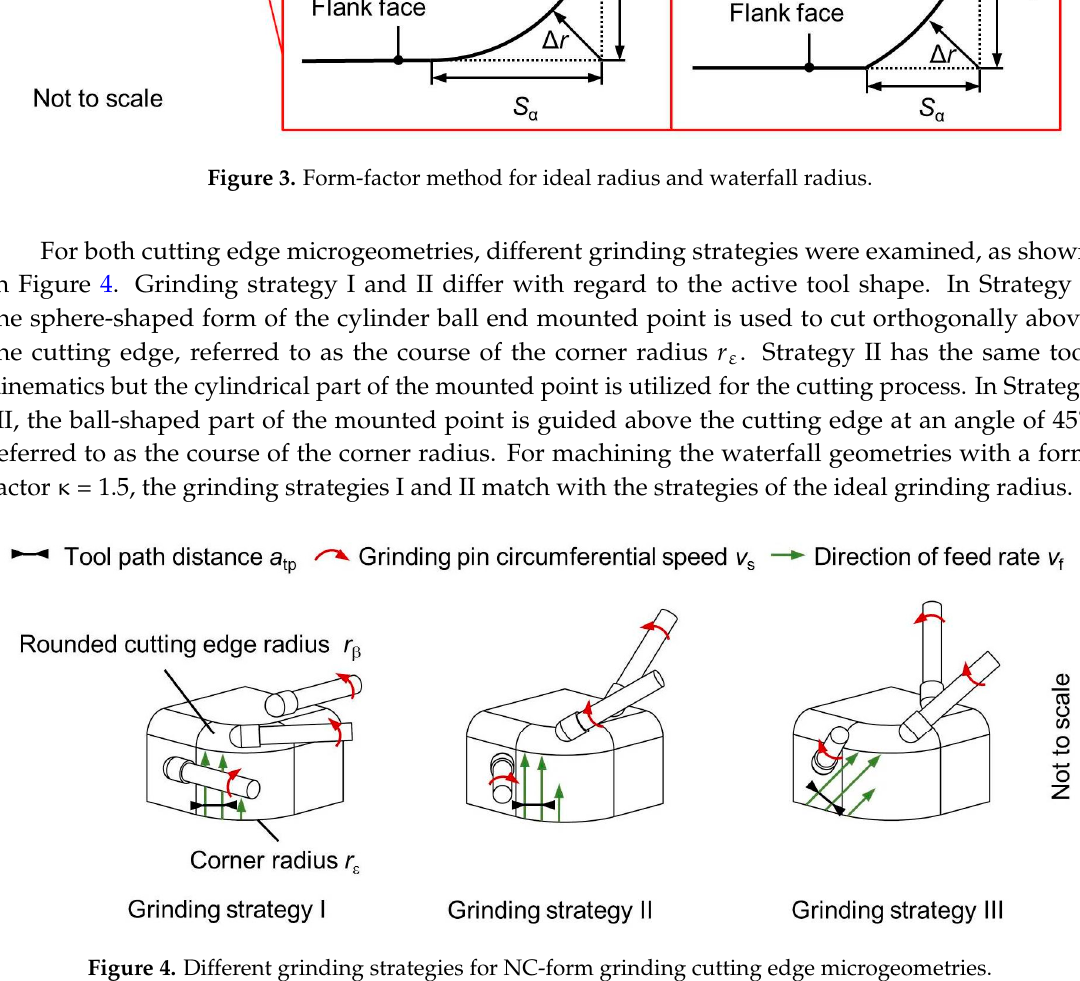
Figure 4. Different grinding strategies for NC-form grinding cutting edge microgeometries.